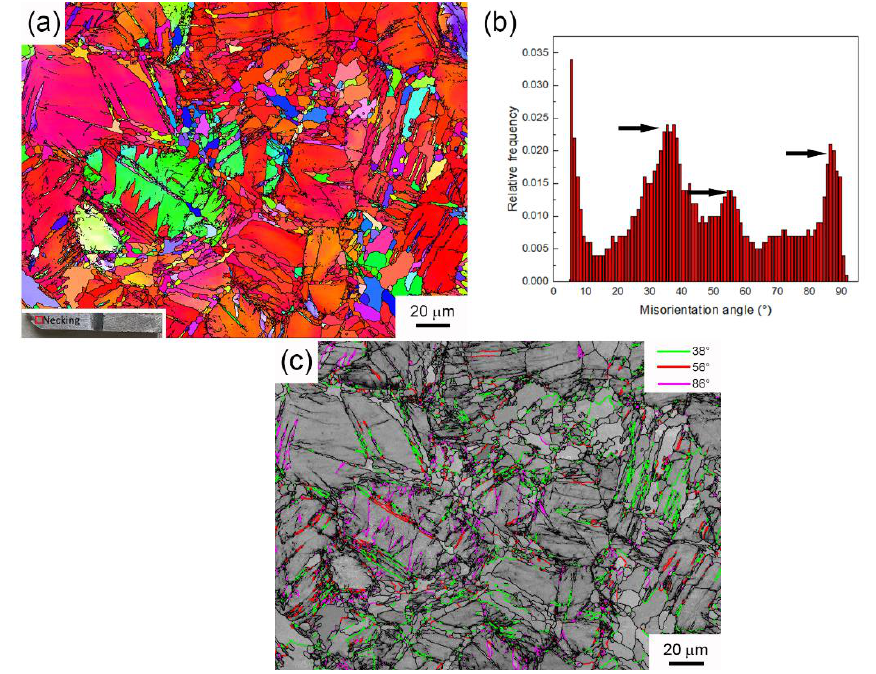
Figure 12. EBSD analysis of the area near the fracture surface of the tensile specimen from a plate annealed at 300 °C: IPF map in ( a ), misorientation angle distribution in ( b ), and grain boundary and twin type analysis in ( c ).